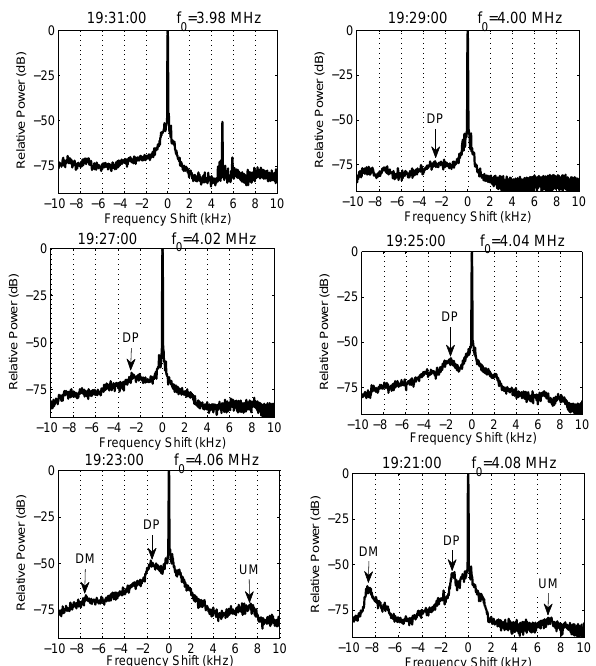
Figure 3. Wideband SEE frequency spectra of HF scattered sig- nals from the EISCAT HF transmitter operating at varying pump frequencies near 3 f ce . The heating direction is along the magnetic zenith. According to DP measurement, f 0 ≈ 3 f c e occurs between 4.04 and